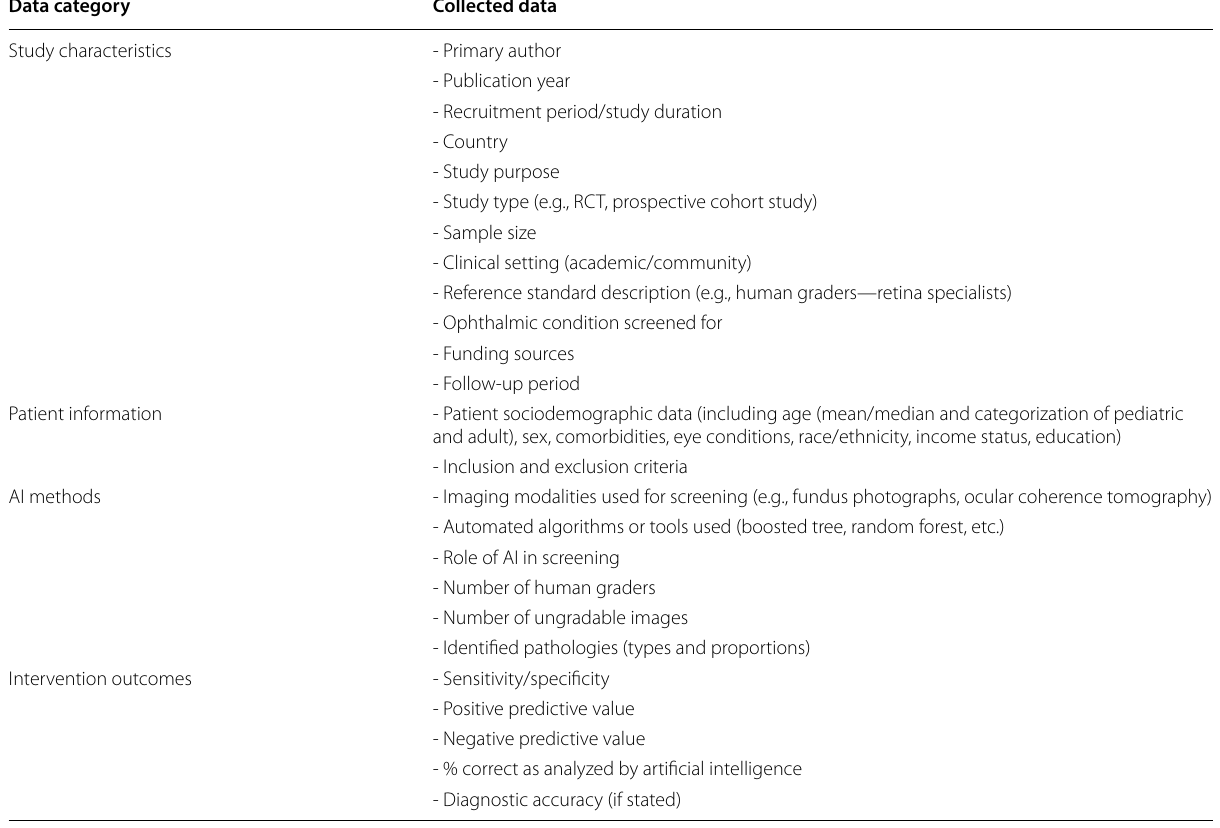
Table 1 Data to be extracted from each study Data category Collected